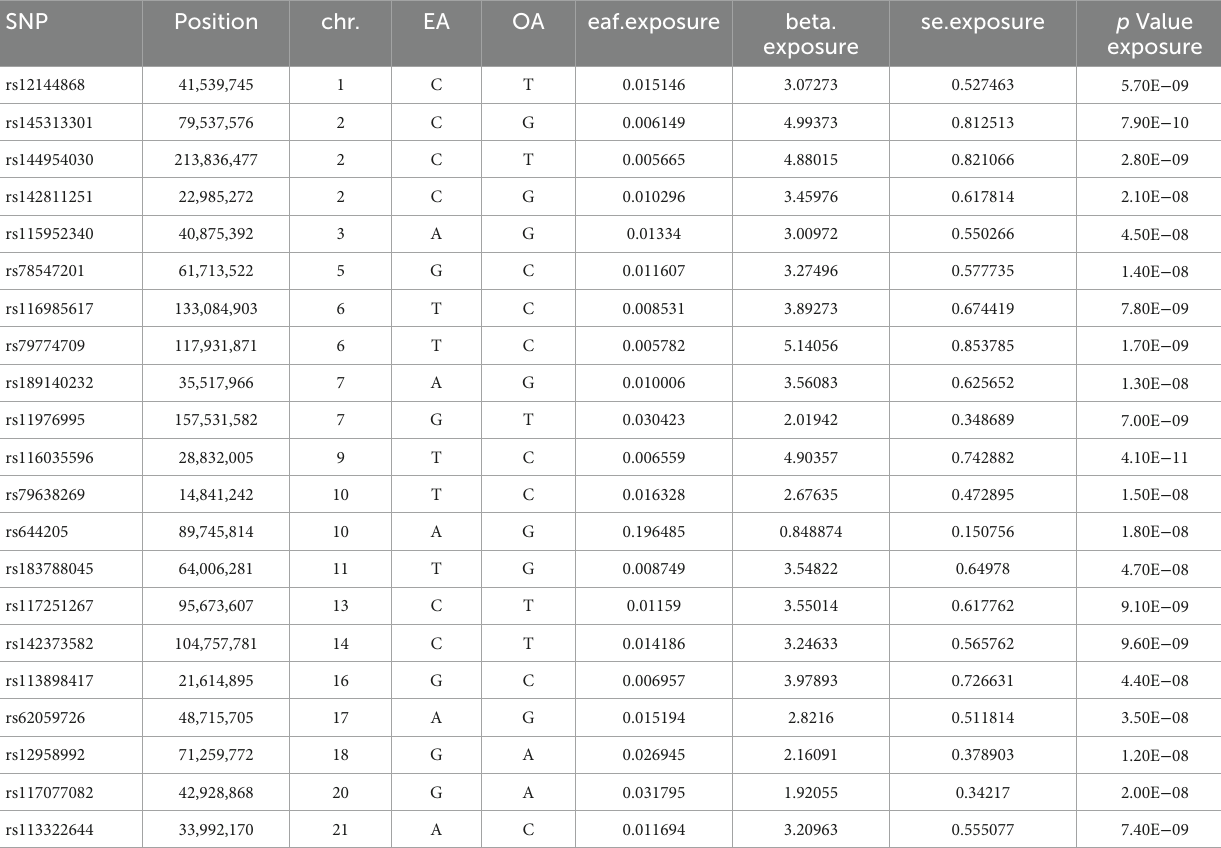
TABLE 1 List of genetic